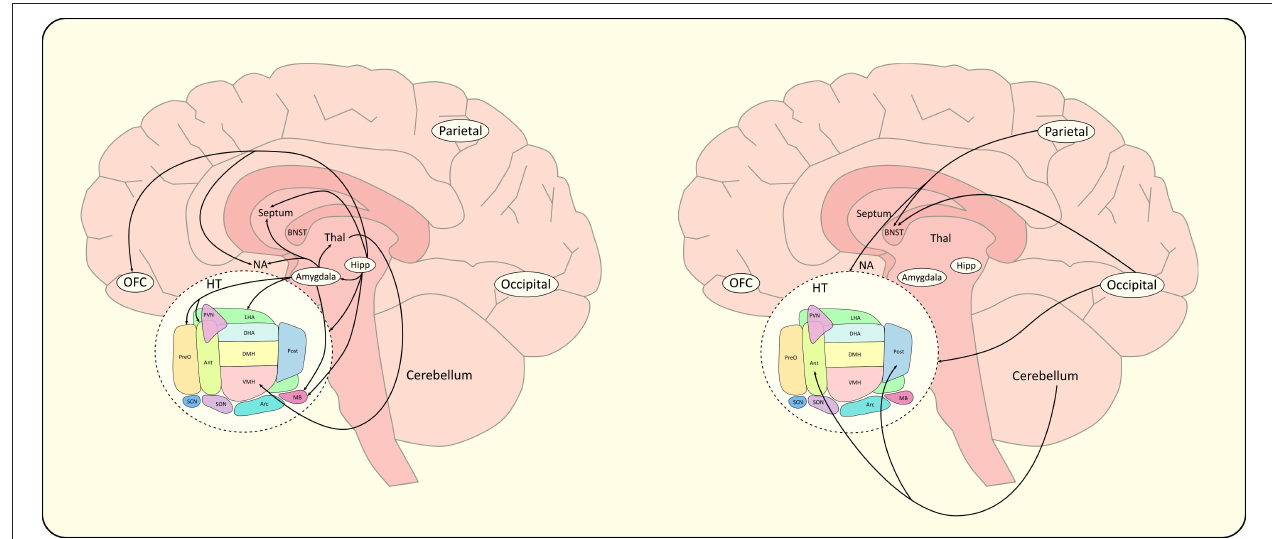
FIGURE 5 | Schematic representations of extra-hypothalamic networks of food intake. For clarity concern, extra-hypothalamic connections reported in the literature have been divided in an appetitive network (left) and a control network (right) . BNST, bed nucleus of the stria terminalis; Hipp, hippocampus; HT, hypothalamus; NA, nucleus accumbens; Parietal, parietal cortex; Occipital, occipital cortex; OFC, orbitofrontal cortex; Thal, thalamus. The schematic sagittal slice of the hypothalamus (HT) includes; Ant, anterior hypothalamus; Arc, arcuate nucleus; DHA, dorsal hypothalamic area; DMH, dorsomedial hypothalamus; LHA, lateral hypothalamic area; MB, mammillary body; Pe, periventricular nucleus; Post, posterior hypothalamic nucleus; PreO, preoptic nucleus; PVN, paraventricular nucleus; SCN, suprachiasmatic nucleus; SON, supraoptic nucleus; VMH, ventromedial